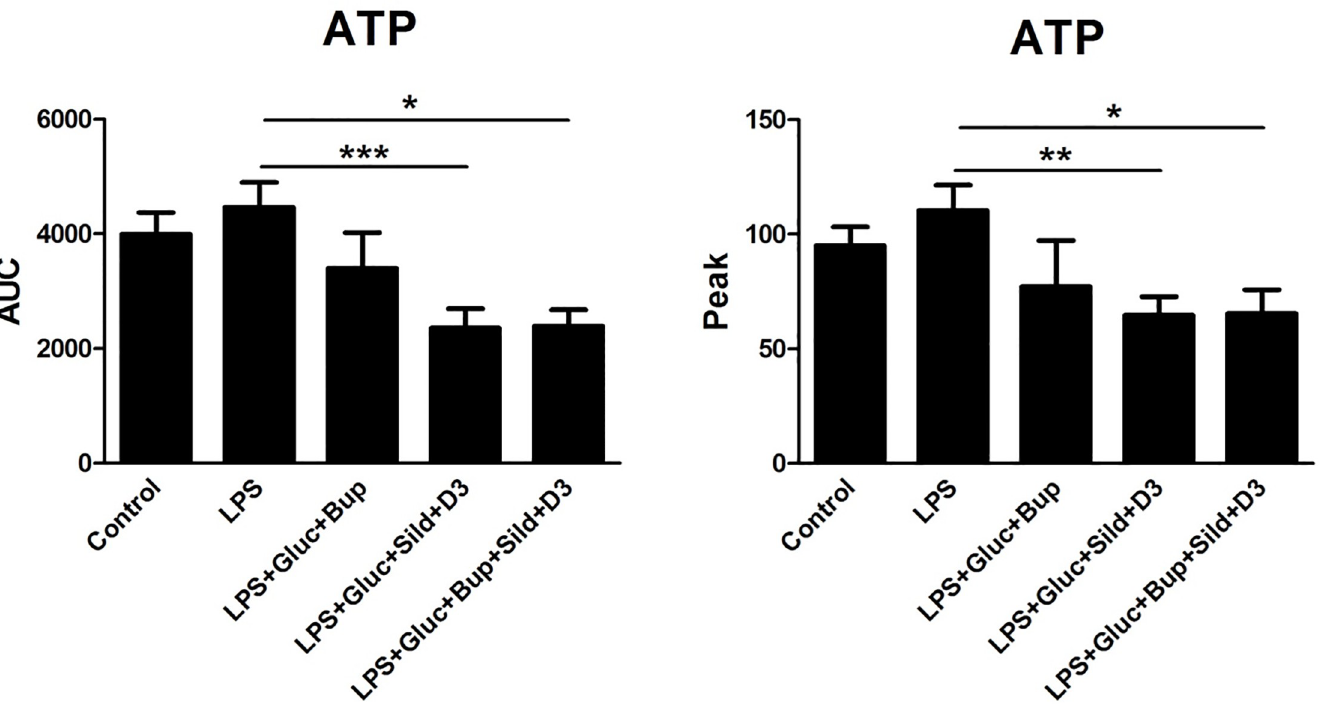
Fig 3. Astrocytes were incubated with the Ca 2+ -sensitive probe FLIPR Calcium 6. ATP (10 − 4 M) was used as a stimulator to detect changes in intracellular Ca 2+ release. The cells were cultivated in 5.5 mM glucose for the entire cultivation period. Ca 2+ responses were measured after the cells were stimulated with ATP (control), incubated with LPS (10 ng/ml) for 24 h, or incubated with LPS for 24 h followed by LPS, 25 mM glucose + bupivacaine (Bup) (10 − 12 M), 25 mM glucose + sildenafil (Sild) (1 μ M) + vitamin D3 (D3) (100 nM), or a combination of all substances for an additional 24 h. The area under the curve (AUC) of the Ca 2+ peak was calculated for each Ca 2+ transient, and the amplitude (peak) was expressed as the maximum increase. The cells were obtained from 4 experiments with quadruple wells in each. The level of significance was calculated against LPS and analyzed using a one-way ANOVA followed by Dunnett’s multiple comparisons test. � P < 0.05, �� P < 0.01, ��� P <